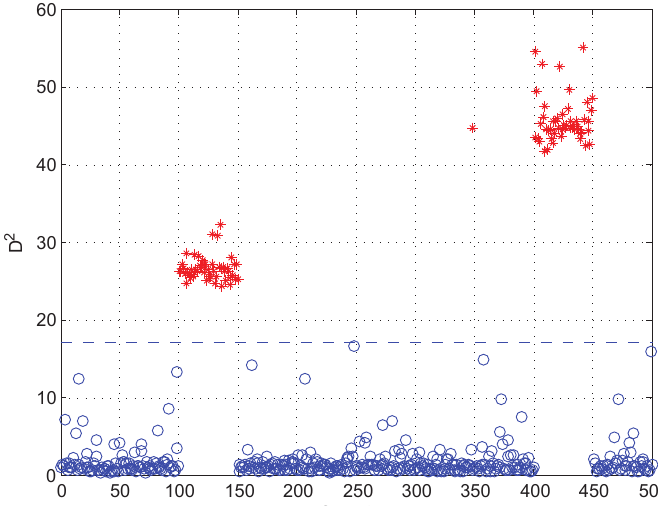
Figure 6. Fault detection result of test data 2.